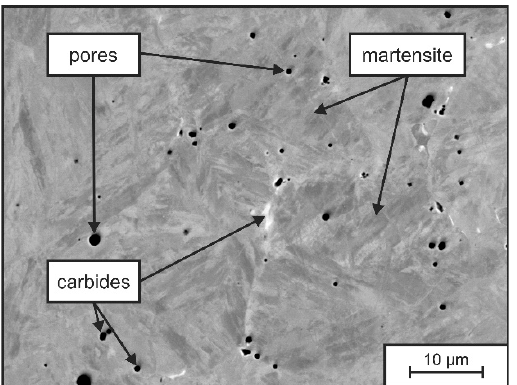
Figure 3. SEM picture of the microstructure of a single weld bead of tool steel X36 in as-welded condition.